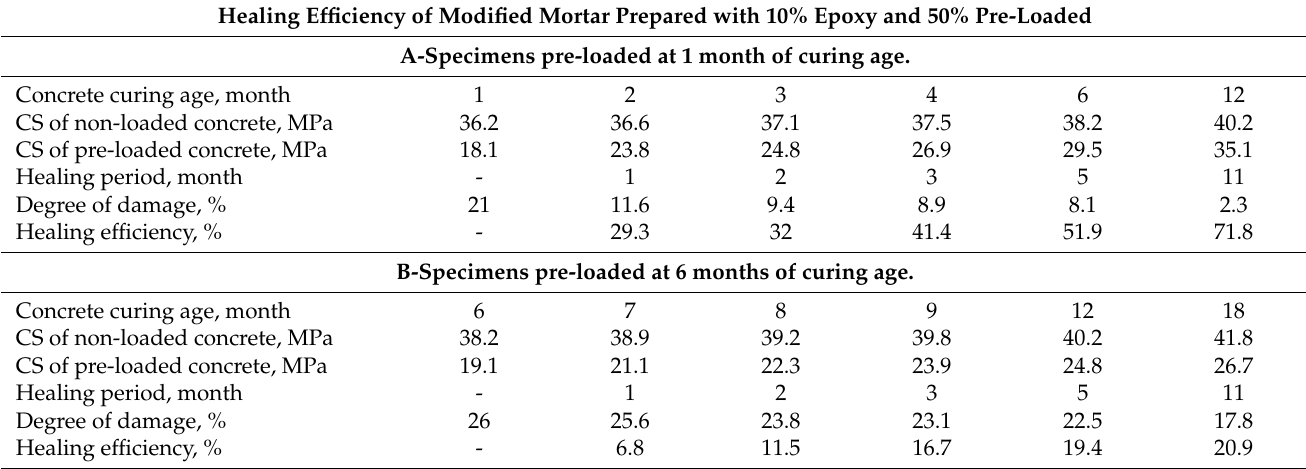
Table 3. Degree of damage and Healing efficiency of epoxy-modified